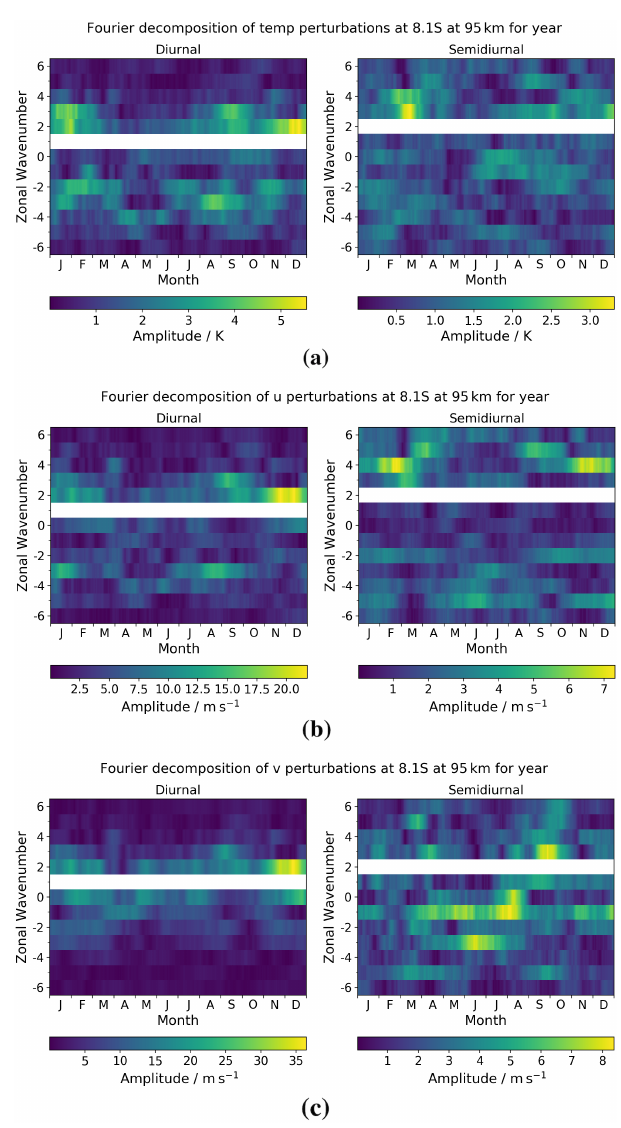
Figure 9. Diurnal and semidiurnal tidal amplitudes as a function of month and zonal wavenumber at the equatorial latitude of As- cension Island (8 ◦ S) for (a) temperature, (b) zonal ( u ) winds, and (c) meridional ( v ) winds. The dominant migrating tidal component is removed in each case for